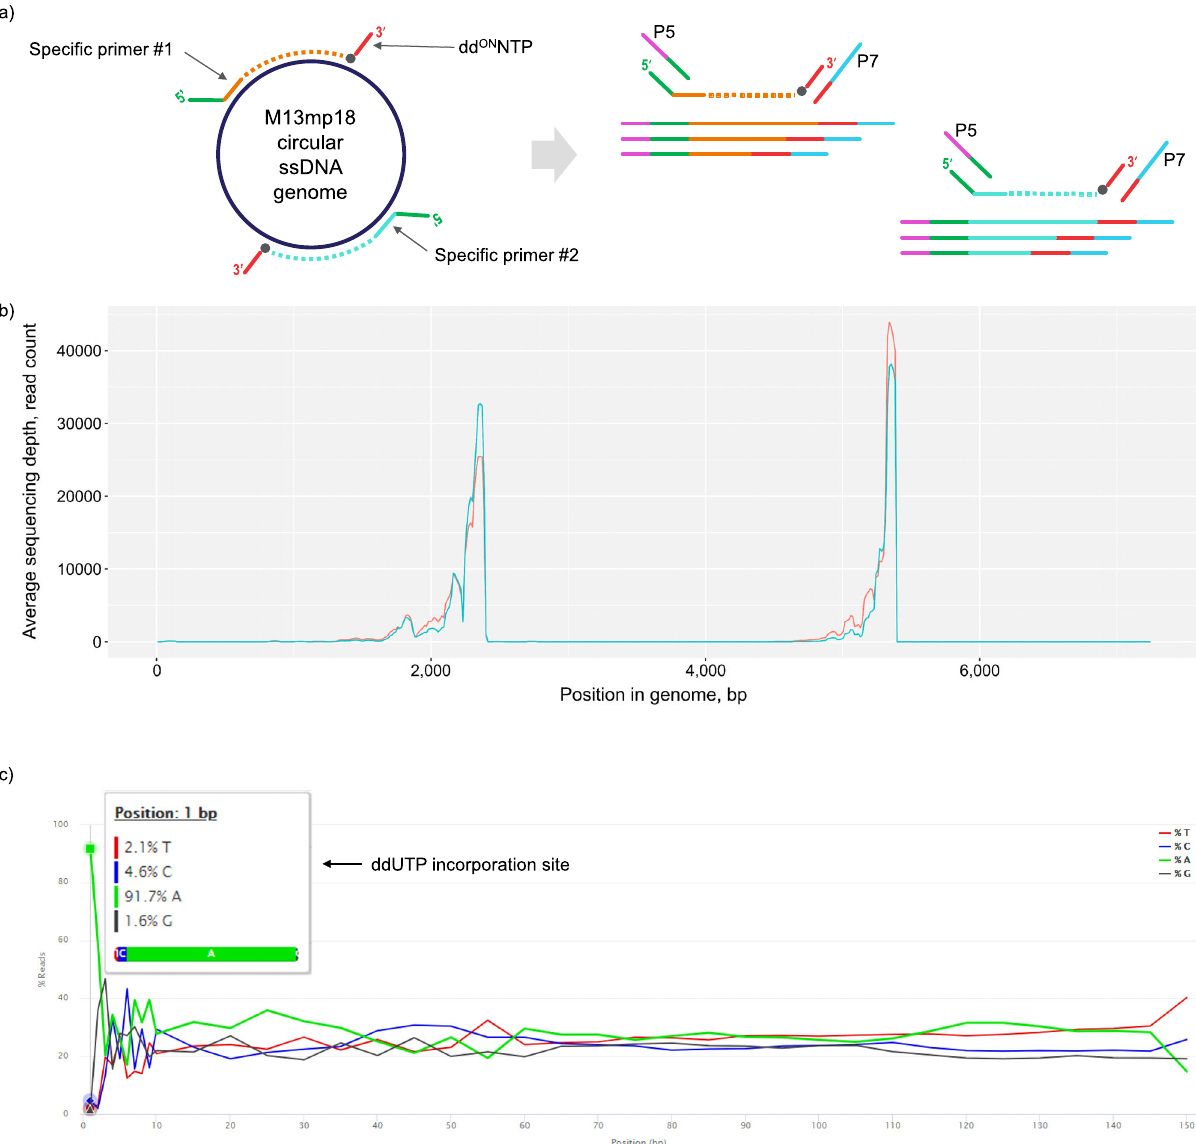
Fig. 4 Semi-targeted sequencing of the M13mp18 viral genome. a A schematic overview of library preparation with dd ON NTP s. b M13mp18 genome coverage. The reads concentrated at two loci with one terminus of sequenced inserts fi xed at the speci fi c priming sites. Another terminus corresponds to the stochastic positions of dd ON UTP incorporation. The orange and blue lines represent technical replicates. c Base composition of sequenced reverse reads. The dominance of A base at the fi rst position indicates a seamless copying of the template around the linker